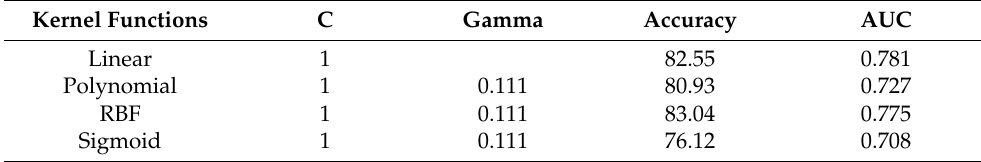
Table 4. Accuracy and AUC for four kernel function with default values C and Gamma on test data set. Kernel